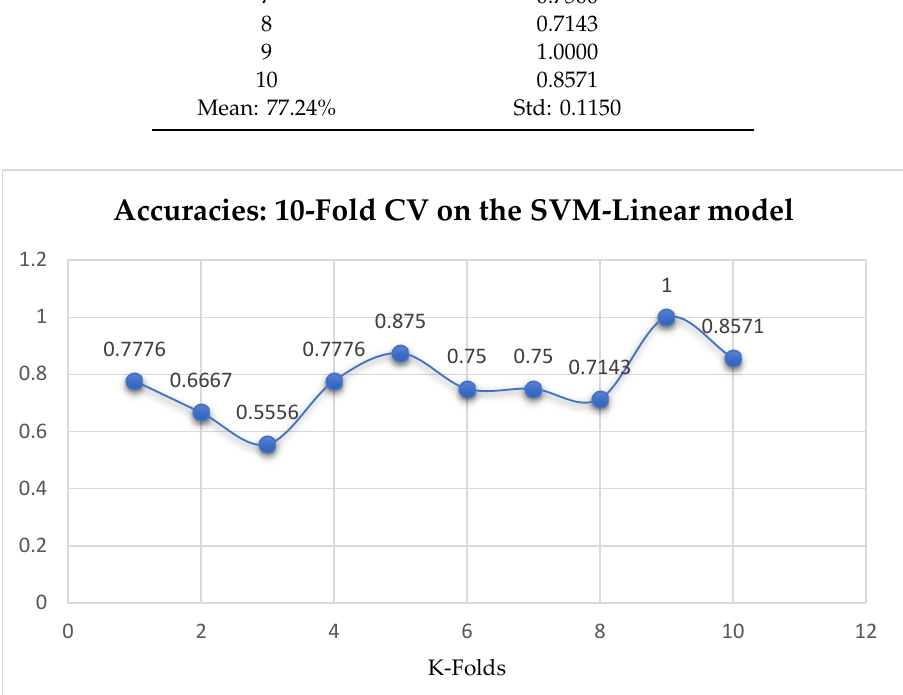
Figure 23. The accuracies achieved by the Folds after performing 10-Fold Cross-Validation on the SVM-Linear model.